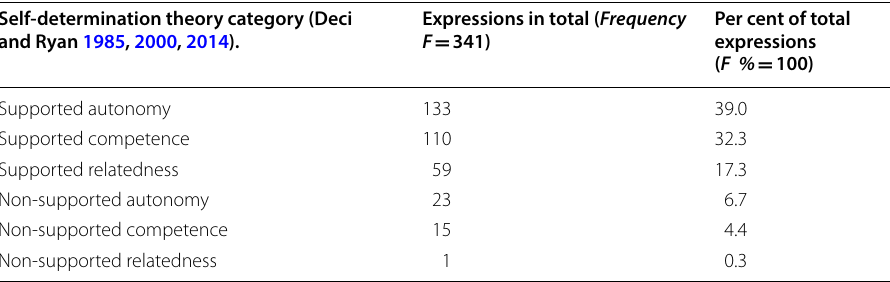
Table 1 Research data classification Self‑determination theory category (Deci and Ryan 1985, 2000,